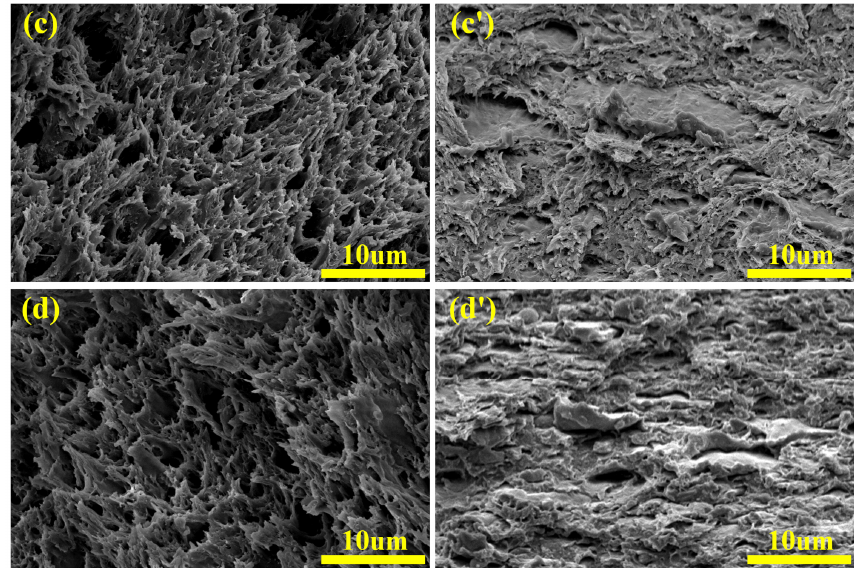
Figure 6. SEM micrographs of tensile fracture surfaces of the rABS/SEBS blends and rABS/SEBS-g-MAH blends: ( a ) rABS/SEBS 95/5; ( a’ ) rABS/SEBS-g-MAH 95/5; ( b ) rABS/SEBS 90/10; ( b’ ) rABS/SEBS-g-MAH 90/10; ( c ) rABS/SEBS 85/15; ( c’ ) rABS/SEBS-g-MAH 85/15; ( d ) rABS/SEBS 80/20; and, ( d’ ) rABS/SEBS-g-MAH 80/20.